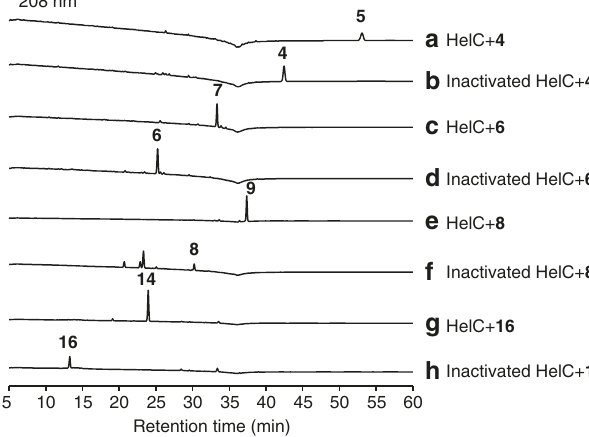
Fig. 6 HPLC analysis of in vitro enzymatic reactions. a 4 with HelC; b 4 with inactivated HelC; c 6 with HelC; d 6 with inactivated HelC; e 8 with HelC; f 8 with inactivated HelC; g 16 with HelC; h 16 with inactivated